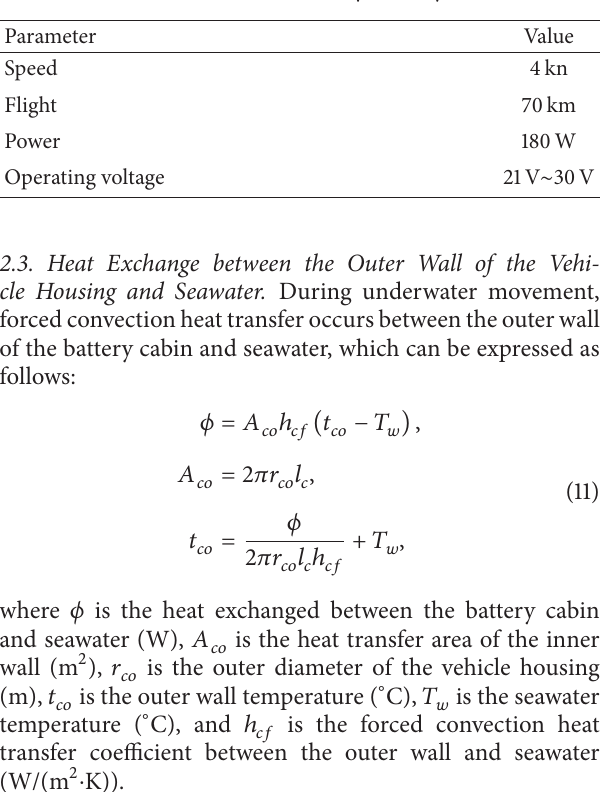
Table 3: Certain underwater vehicle dynamic system indicators.